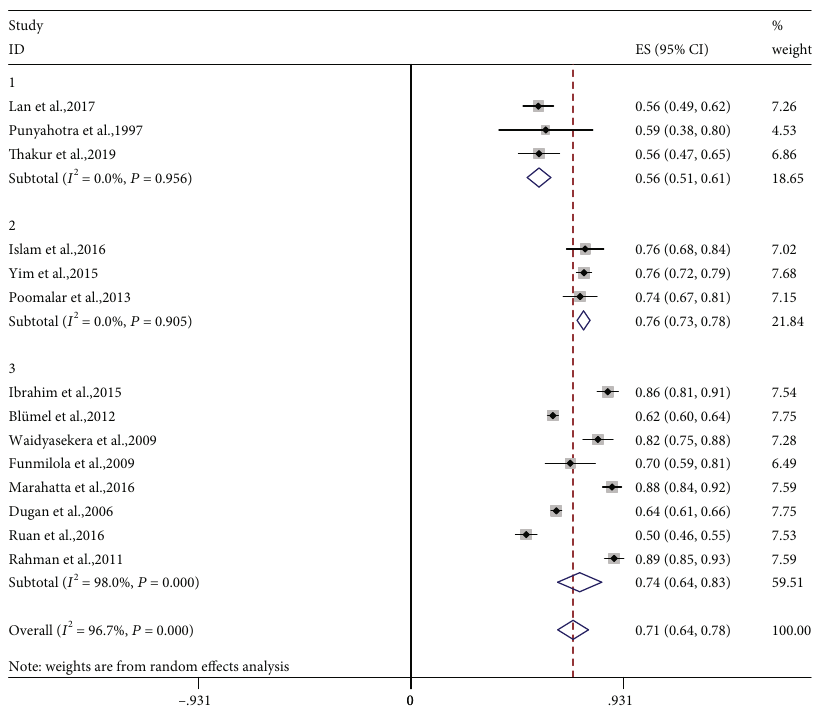
Figure 2: Meta-analyses of the estimated MSP prevalence in perimenopausal women. Fourteen studies were included in the analysis. ES (95% CI): e ff ect sizes, (95% con fi dence interval).